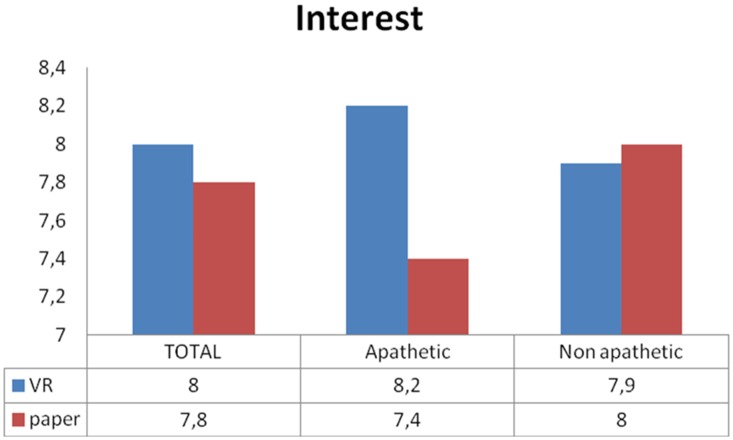
Self-report questionnaires.Mean scores for the self-report questionnaires in the Virtual Reality (VR, blue) and the classical paper version (red) conditions. Rating scale: 0 to 10. *p < .05 in the ANOVA.